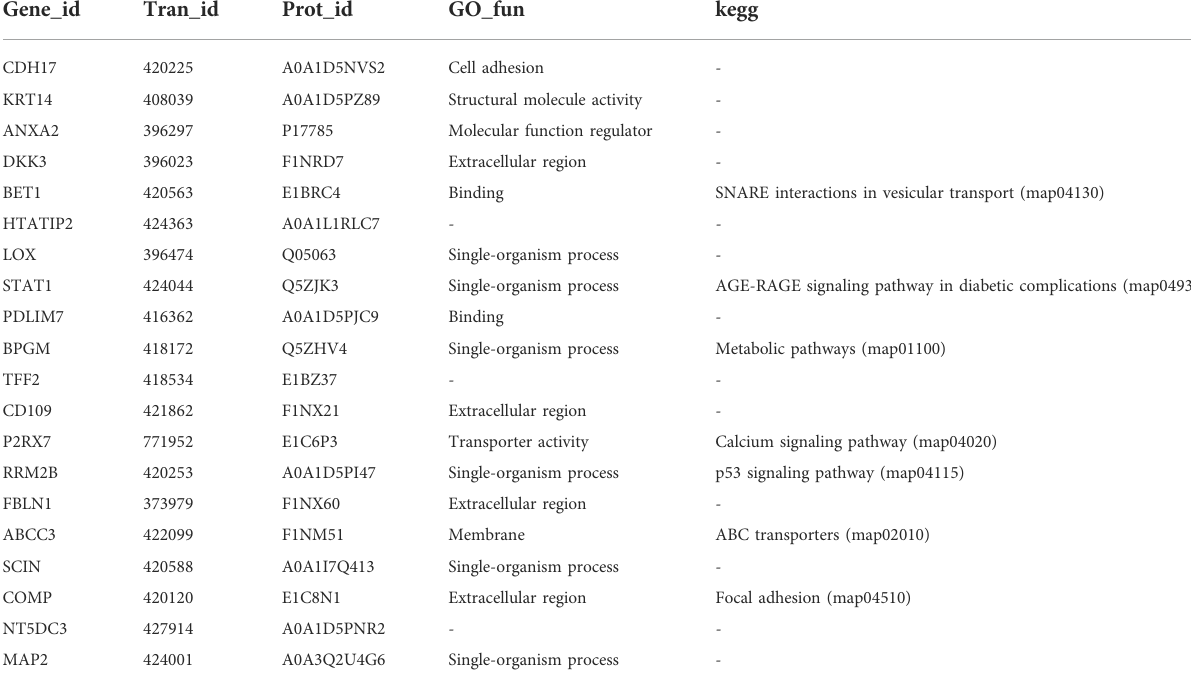
TABLE 2 Proteins/genes differentially expressed in both the proteome and